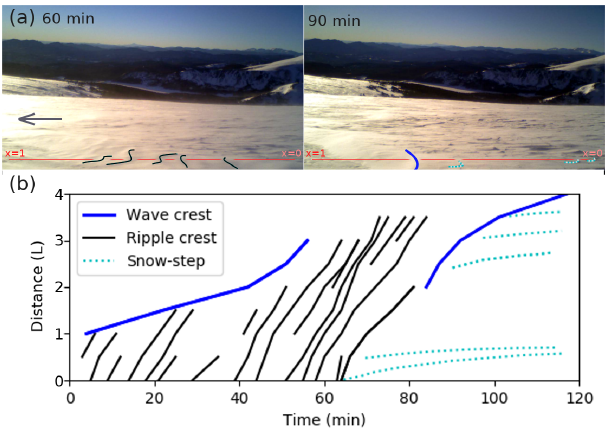
Figure 9. A rippled wave travels across Niwot Ridge from 06:40 to 08:40 on 19 January 2017, video S1 at 4:40. The wave is covered by ripples, which eventually collapse into a single crest, and deposits fresh snow as it passes. This in turn develops snow steps. Distance is measured in arbitrary unit L = 1 ± 0 . 3m.